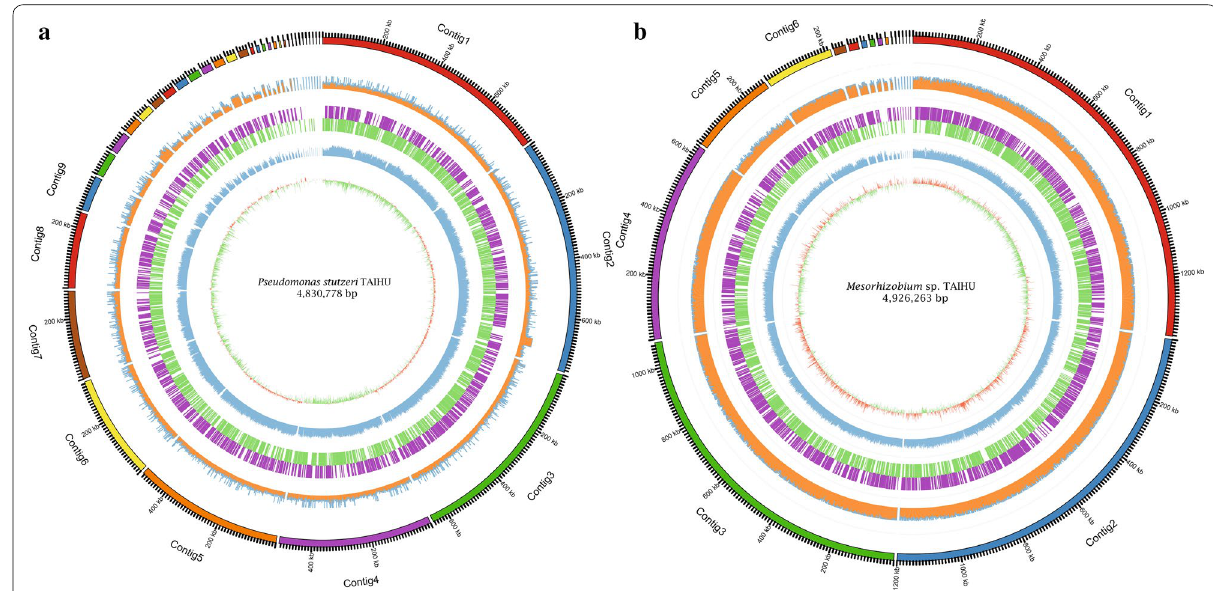
Fig. 3 The representation of two bacteria genome sequence recovered from the coculture. The genomic characterization of Mesorhizobium sp. TAIHU ( a ) and Pseudomonas stutzeri TAIHU ( b ) is illustrated in the graphic representation generated by Circos program. The rings from outer to inner indicate the contigs, read coverage of each contigs (orange, 1 Kbp window), gene distribution on each strand (positive: purple, negative: green), GC content (blue, 1 Kbp window) and GC skew (orange above and green below zero, 1 Kbp